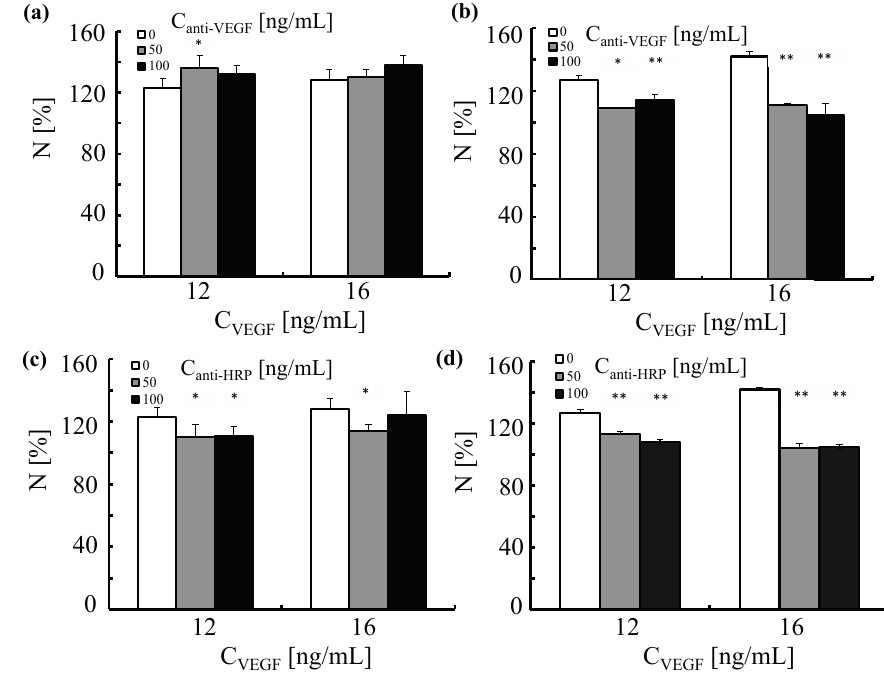
Figure 16. The effect of Au NPs functionalized with anti-VEGF or anti-HRP antibody on the proliferation of human umbilical vein endothelial cells triggered by VEGF. HUVECs were first exposed to Au NPs functionalized with ( a , b ) anti-VEGF or ( c , d ) anti-HRP antibodies. The NPs were added to the cells to reach concentrations of the antibodies equal to C anti-VEGF and C anti-HRP of 50 (grey bars) and 100 ng/L (black bars) (adjusted by the NP concentration by knowing the number R P/NP of antibodies per NP as shown in Table 1). This was followed by the incubation with VEGF ( C VEGF = 12 and 16 ng/mL) for ( a , c ) 24h and ( b , d ) 48 h. The number of cells was normalized to 100% for untreated control cells. * p < 0.01; ** p < 0.001 ( versus cells treated with VEGF